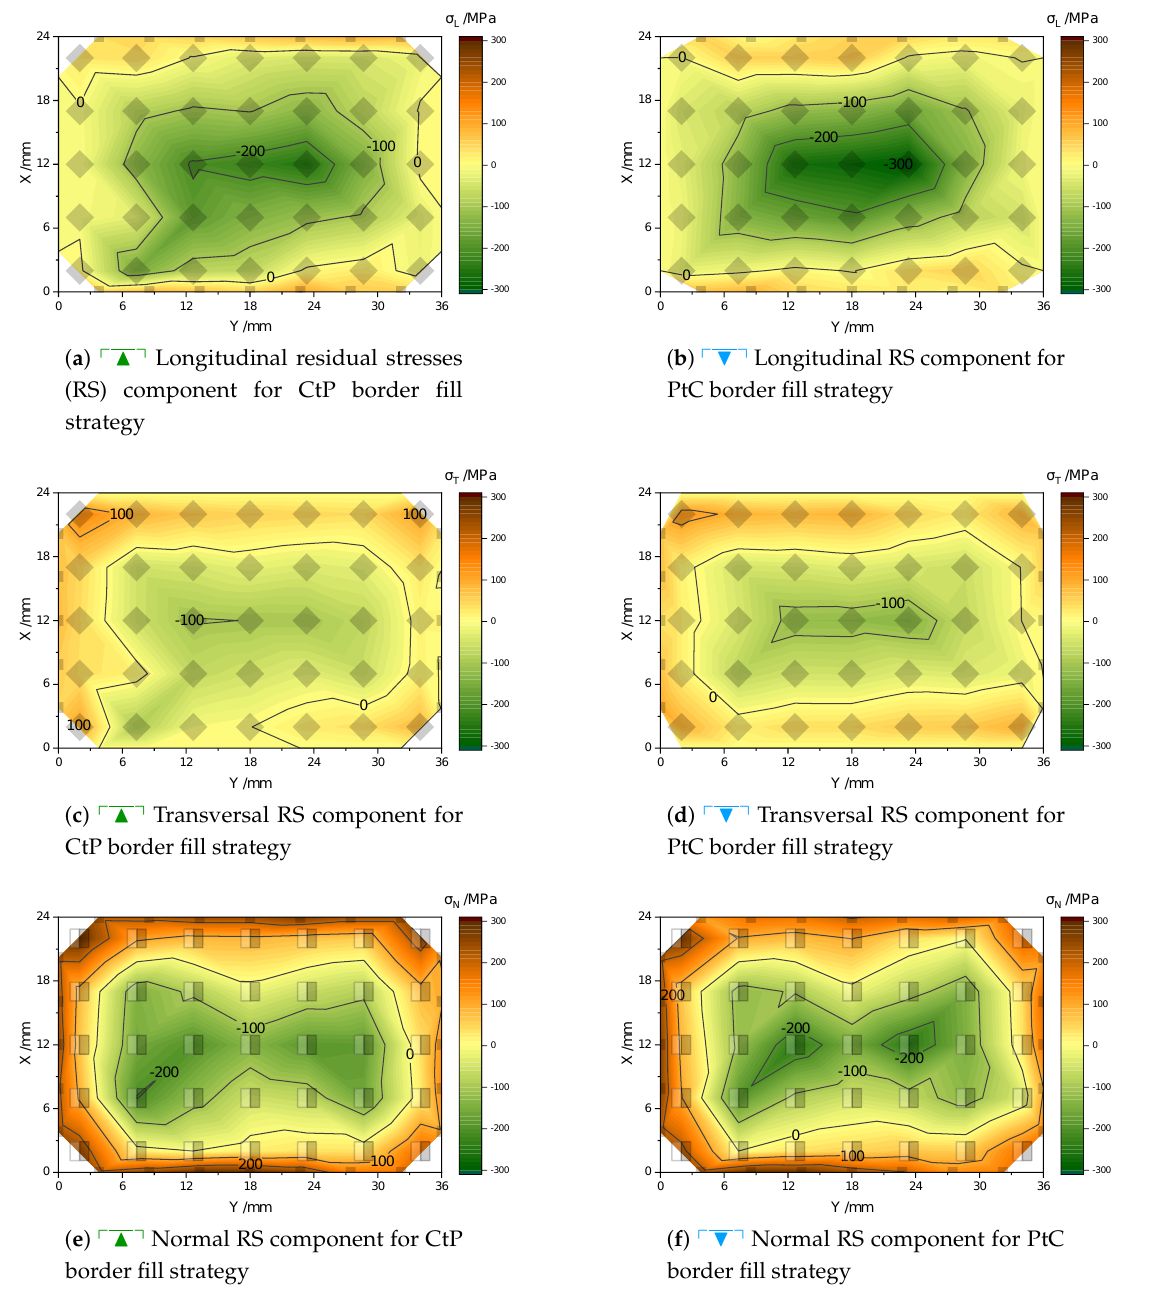
Figure 5. Comparison of RS maps of the tw scan strategies including results from lab X-ray diffraction at the surface (The big semi-translucent squares in the bulk represent the almost cubic ND gauge volume (orientated differently for different stress components), whereas the small semi-translucent squares at the edges represent the lab X-ray measurement